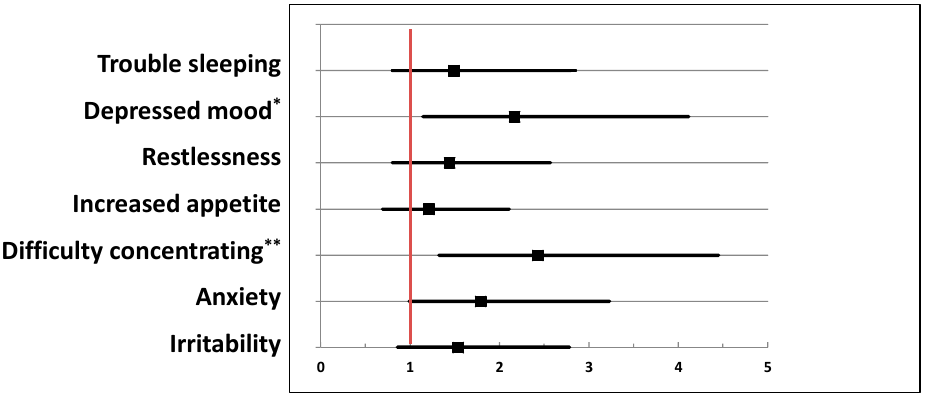
Figure 2. Risk of DSM-V tobacco withdrawal symptoms in electronic- or combustible-cigarette users with depression history compared to no depression history ( N = 457). * p < 0.05; ** p < 0.01: results from weighted logistic regression analyses; adjusted odds ratios (and 95% CIs) after controlling for frequency of nicotine use per day, age, and gender; an odds ratio above 1 indicates increased risk of symptom and below 1 decreased risk.